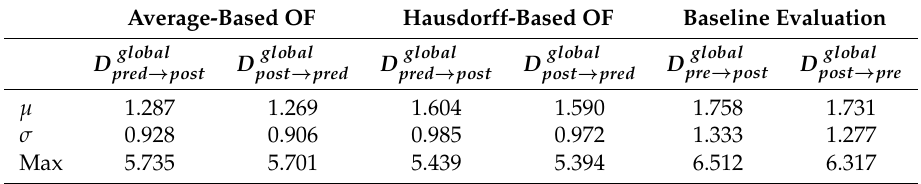
Table 12. Numerical evaluation: Global distances (in mm) between predicted PCLs and post-surgery models using GBR. The training set is sampled with rate of 65% and 75% due to average and Hausdorff OFs, respectively.